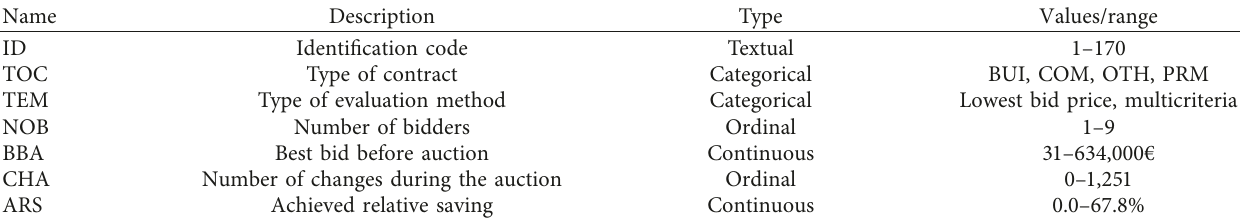
Table 2: Characteristics (name, description, type, and values) of the variables in the construction auctions dataset. Name